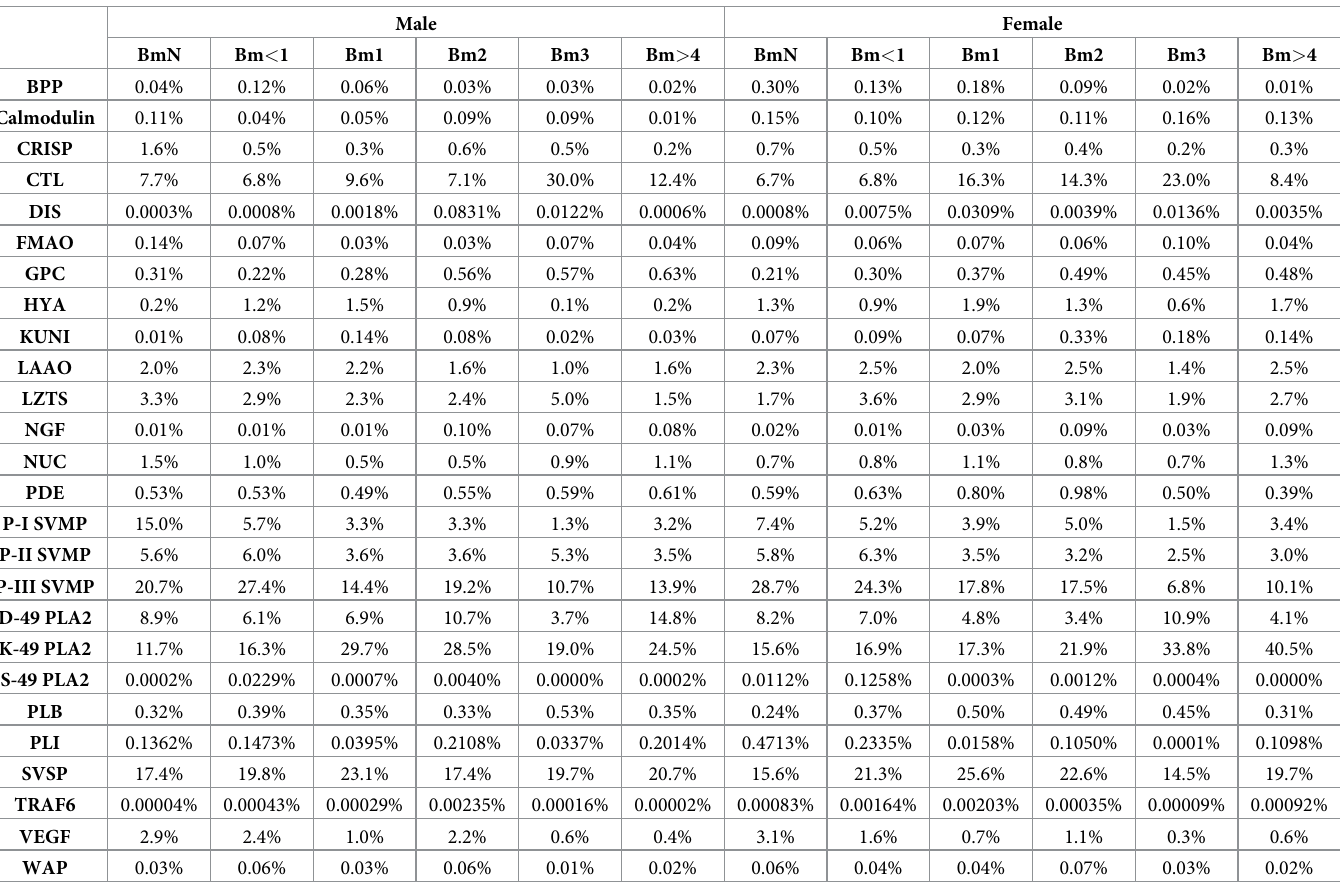
Table 2. Relative abundance of the protein families obtained in each venom by